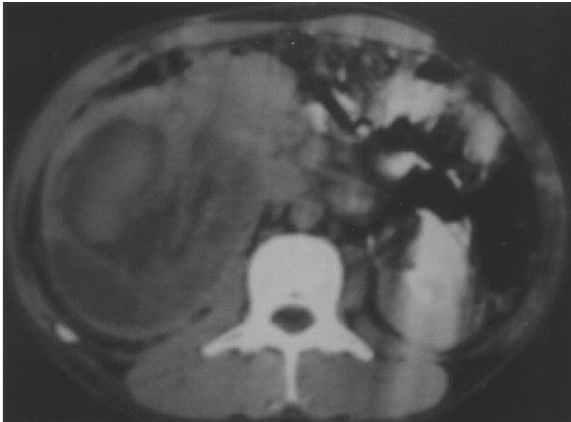
Figure 1 – Abdominal computed tomography evidencing a vo- luminous tumoral mass in right